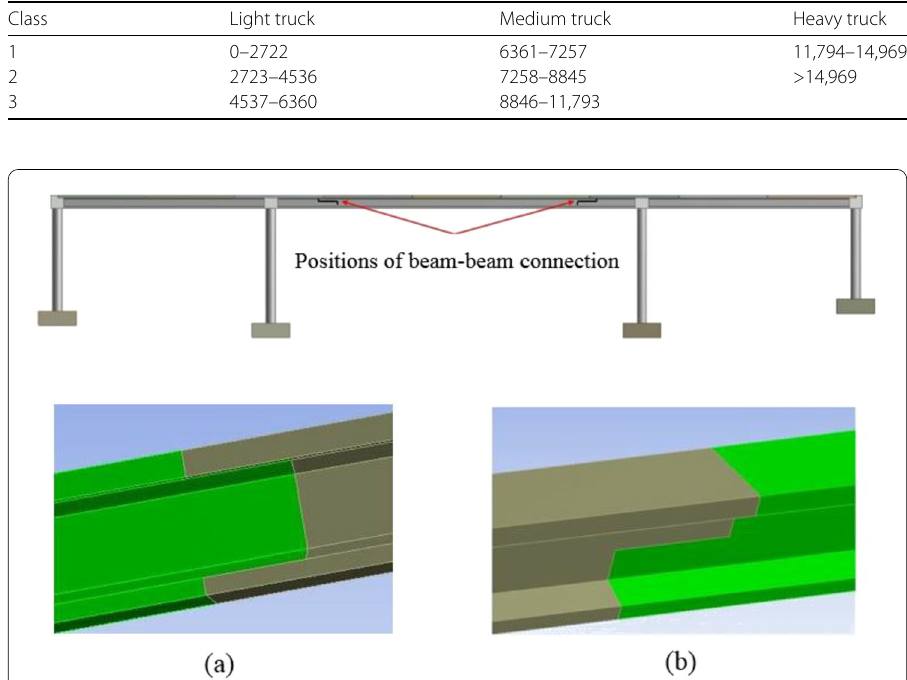
Figure 4 Beam–beam connection geometries. Beam–beam connection with two different shaped geometries: ( a ) half-full beam–beam shape; ( b ) half beam–beam shape